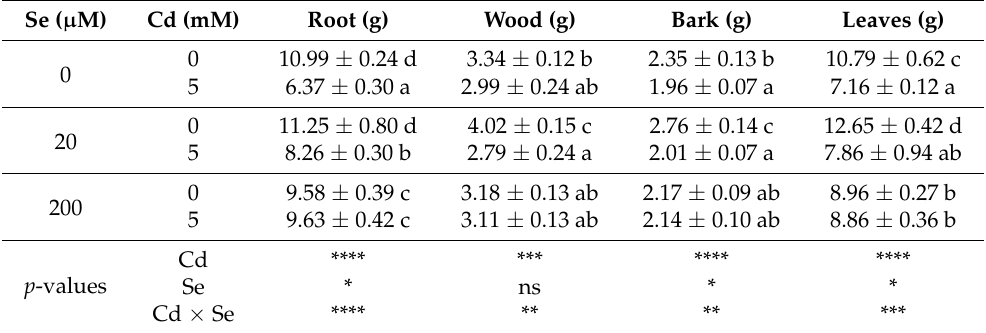
Table 2. The biomass of the roots, wood, bark, and leaves of J. regia (variety Xinfeng) in different